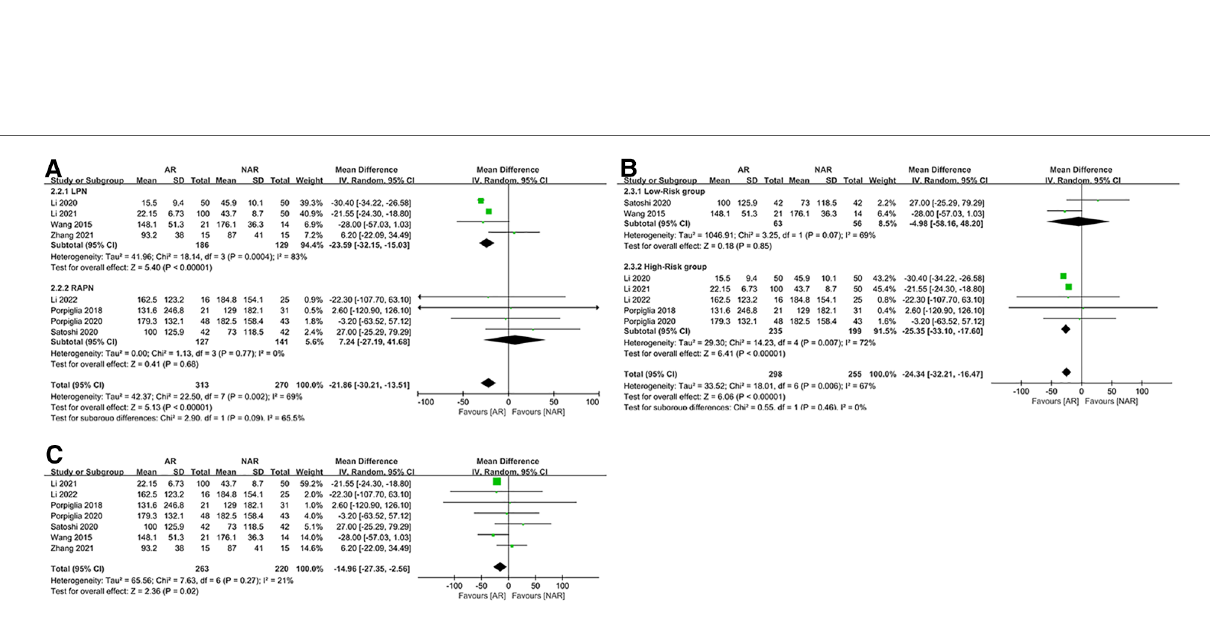
FIGURE 3 ( A ) Subgroup analysis by surgical technique for EBL; ( B ) subgroup analysis performed by the risk of the surgery for EBL; ( C ) EBL excluding Li